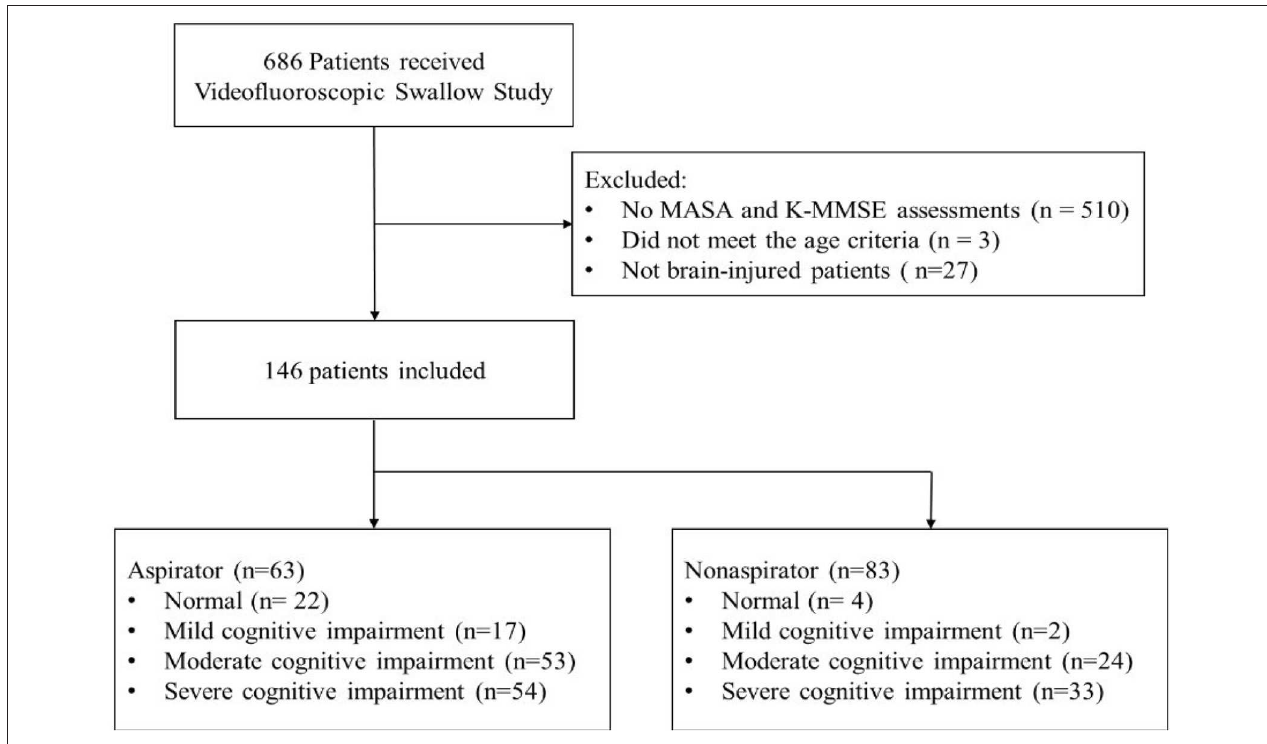
FIGURE 1 | Flowchart of the study and